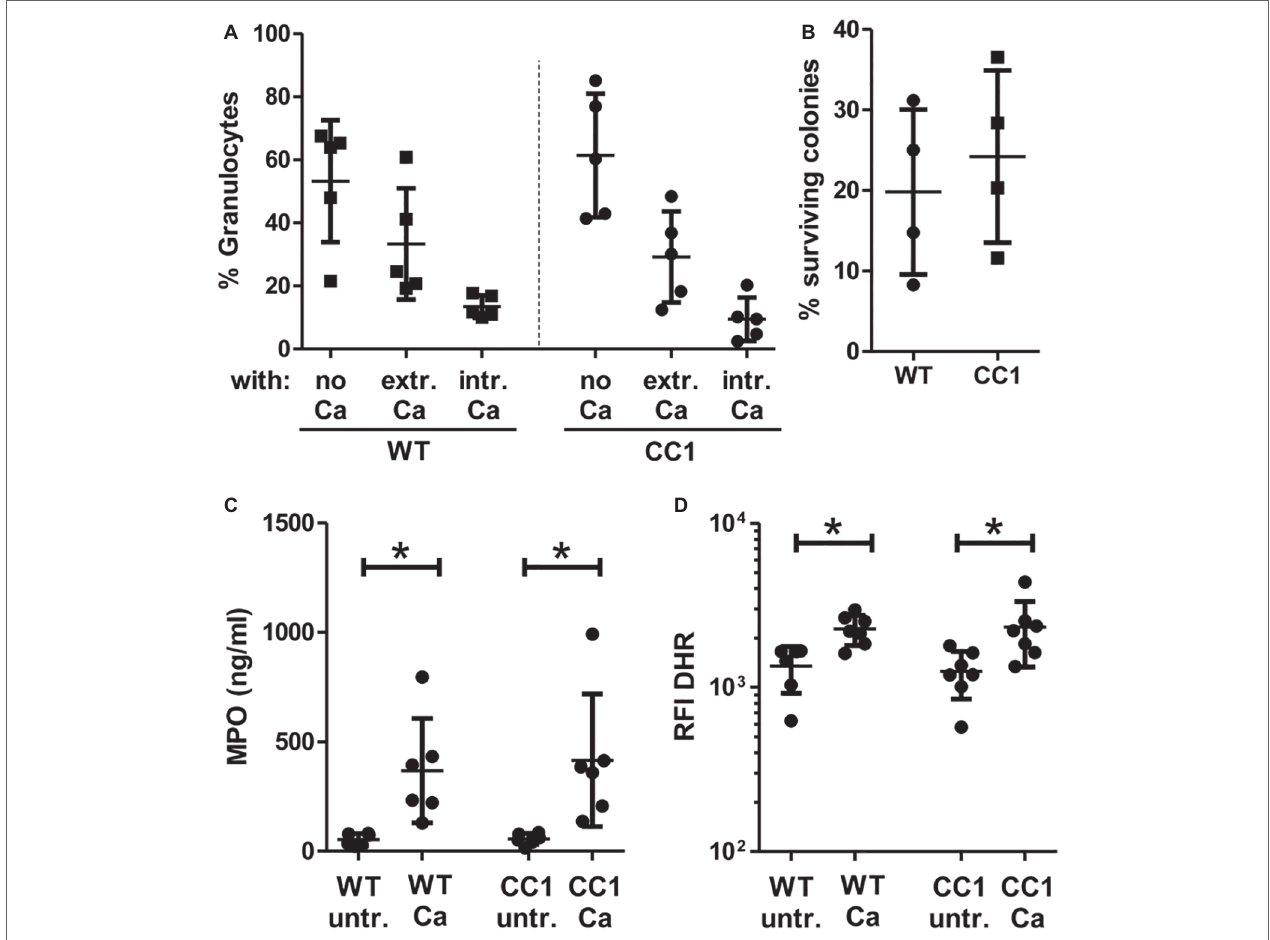
FIGURE 8 | CC1 BMNs do not differ from WT BMNs in their fungicidal reaction to C. albicans . BMNs were isolated from femurs of human CEACAM1-transgenic mice (“CC1”) and their wild-type littermates (“WT”). (A) The ability of BMNs from both genotypes to bind and phagocytose C. albicans was tested by infecting BMNs for 20 min with living, FITC-labeled C. albicans yeast cells (MOI 20). Cells were fixed and counterstained by indirect immunofluorescence for mouse CEACAM1 and extracellular Candida cells. Micrographs were analyzed for phagocytosis by counting BMNs without contact to Candida cells (“no Ca”), BMNs with attached, extracellular Candida cells (“extr. Ca”, FITC staining and anti- Candida antibody staining), and BMNs with intracellular/phagocytosed Candida cells (“intr. Ca”, FITC staining only). Statistical analysis: one-way ANOVA with Bonferroni post-tests. (B) Overall candidacidal activity of BMNs from both genotypes was tested by incubating 2.5 × 10 5 BMNs with 2.5 × 10 4 Candida yeast cells (MOI 0.1) or yeast cells alone for 60 min. Candida CFUs were counted after plating different dilutions on YPD agar. Data are shown as % of yeast cells without BMN. Unpaired, two-sided Student’s t test ( p = 0.574). (C) Concentrations of released myeloperoxidase (MPO) were determined by ELISA in cell culture supernatants from BMNs that were either left untreated or stimulated with live C. albicans yeast cells (MOI 10) for 60 min. Statistical analysis: one-way ANOVA with Bonferroni post-tests. (D) In order to measure the induction of reactive oxygen species, BMNs were pre-incubated with dihydrorhodamine 123 (DHR) fluorigenic probe and either left untreated (“untr.”) or stimulated with UV-killed C. albicans germ tubes (MOI 10; “Ca”) for 15 min and analyzed by flow cytometry for the relative fluorescence intensity (RFI) of intracellular oxidized DHR. Statistical analysis: one-way ANOVA of logarithmized data with Bonferroni